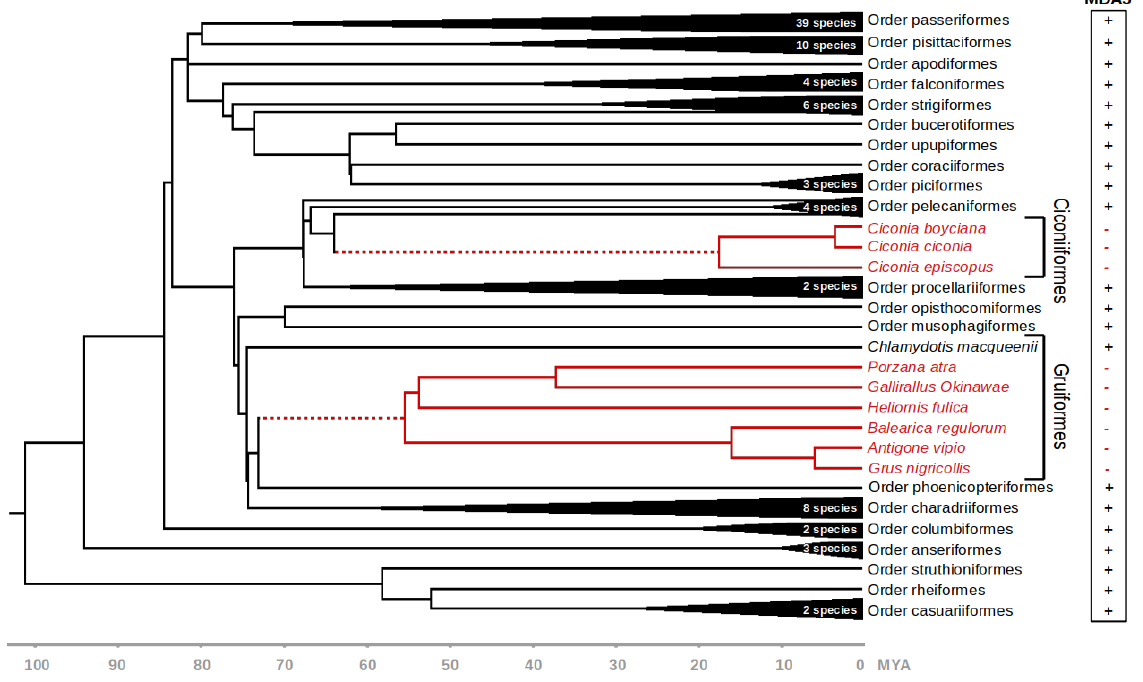
Figure 1. Presence or absence of functional MDA5 gene in various avian species. Evolution of avian species analyzed in this study is shown by a chronogram obtained from BirdTree.org [23]. Orders Ciconiiformes and Gruiformes—where disruption of MDA5 gene was observed—are shown in detail. Full red lines indicate a lineage with nonfunctional MDA5 gene and dashed red lines indicate the predicted evolutionary time interval of the inactivation event. Time scale axis is shown below. MYA—million years ago.